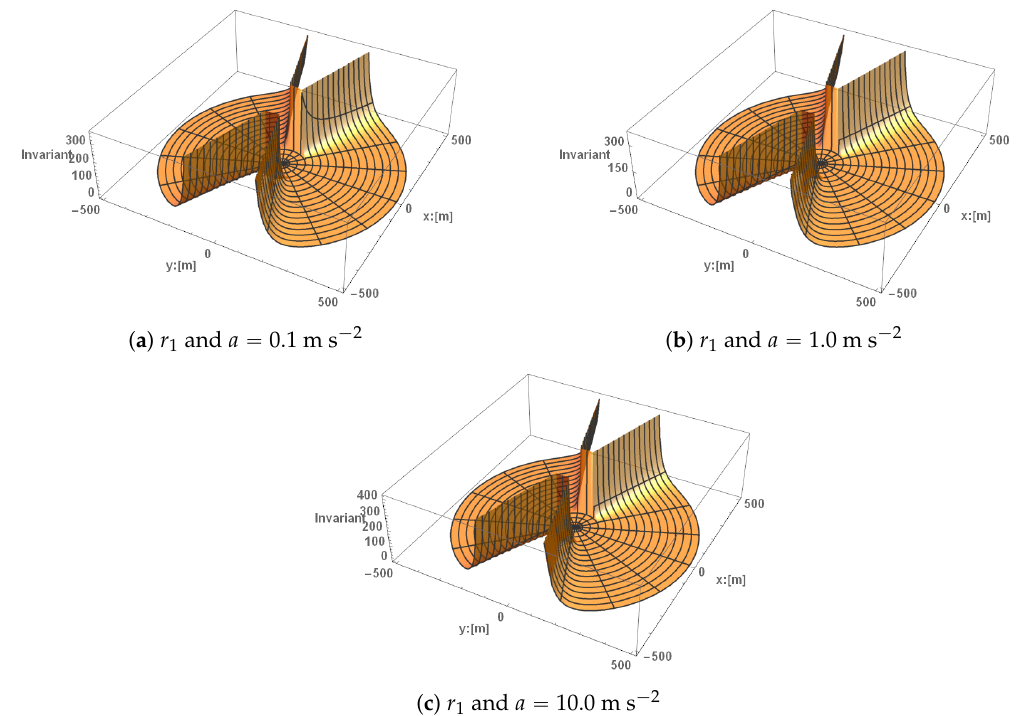
Figure A4. The acceleration, a , of the invariant r 1 is plotted in the figures above. The other parameters were set to be σ “ 50,000 m ´ 1 , ρ “ 100 m, and t “ 1 s. The plots were rendered using Mathematica’s ® RevolutionPlot3D. It plots a function by rotating the function around the z-axis. The amount that the space diverges from being flat is represented by the invariant function’s magnitude, and its amount is labeled on the vertical axis. The x and y-axis are displayed on the plots, and they display the distance from a spaceship in the flat portion at the center of each figure. Each radial line in the plot corresponds to a distance of approximately 33 m. The constant portion to the right of the harbor is to the front of the warp bubble, and the constant portion to the left of the harbor is the back of the warp